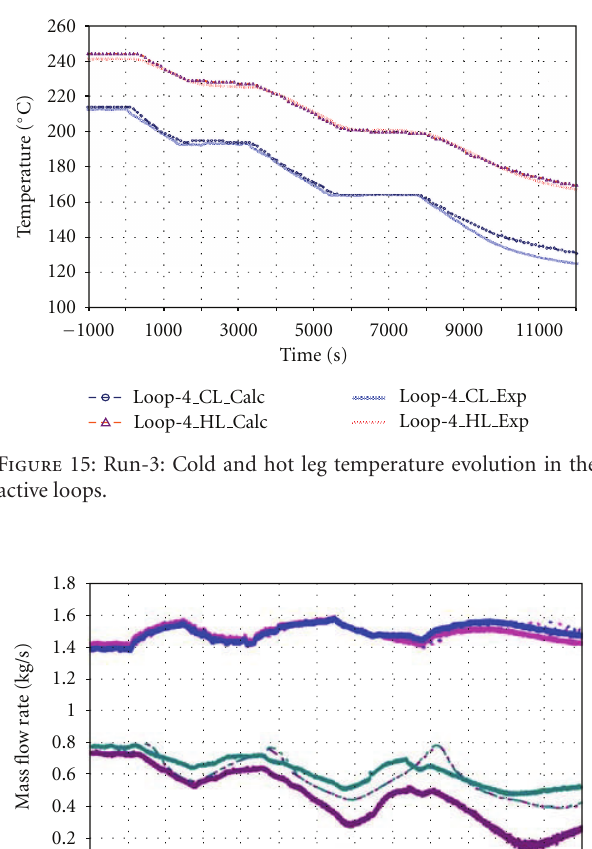
due to the di ff erences in the measured flow rates that exist between loop-1 and loop-3. This di ff erence is most probably due to geometric di ff erences between loop-1 and loop-3, and also to some mixing e ff ect in the upper part of the downcomer that are not modelled in the CATHARE model.